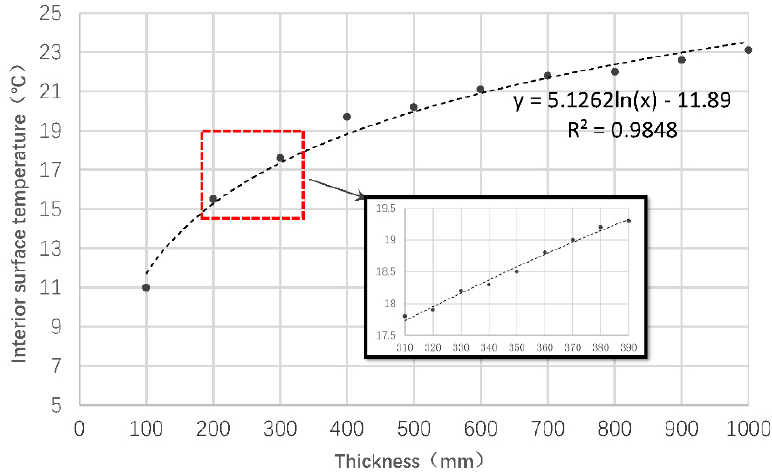
Figure 11. Relationship between the thickness and interior surface